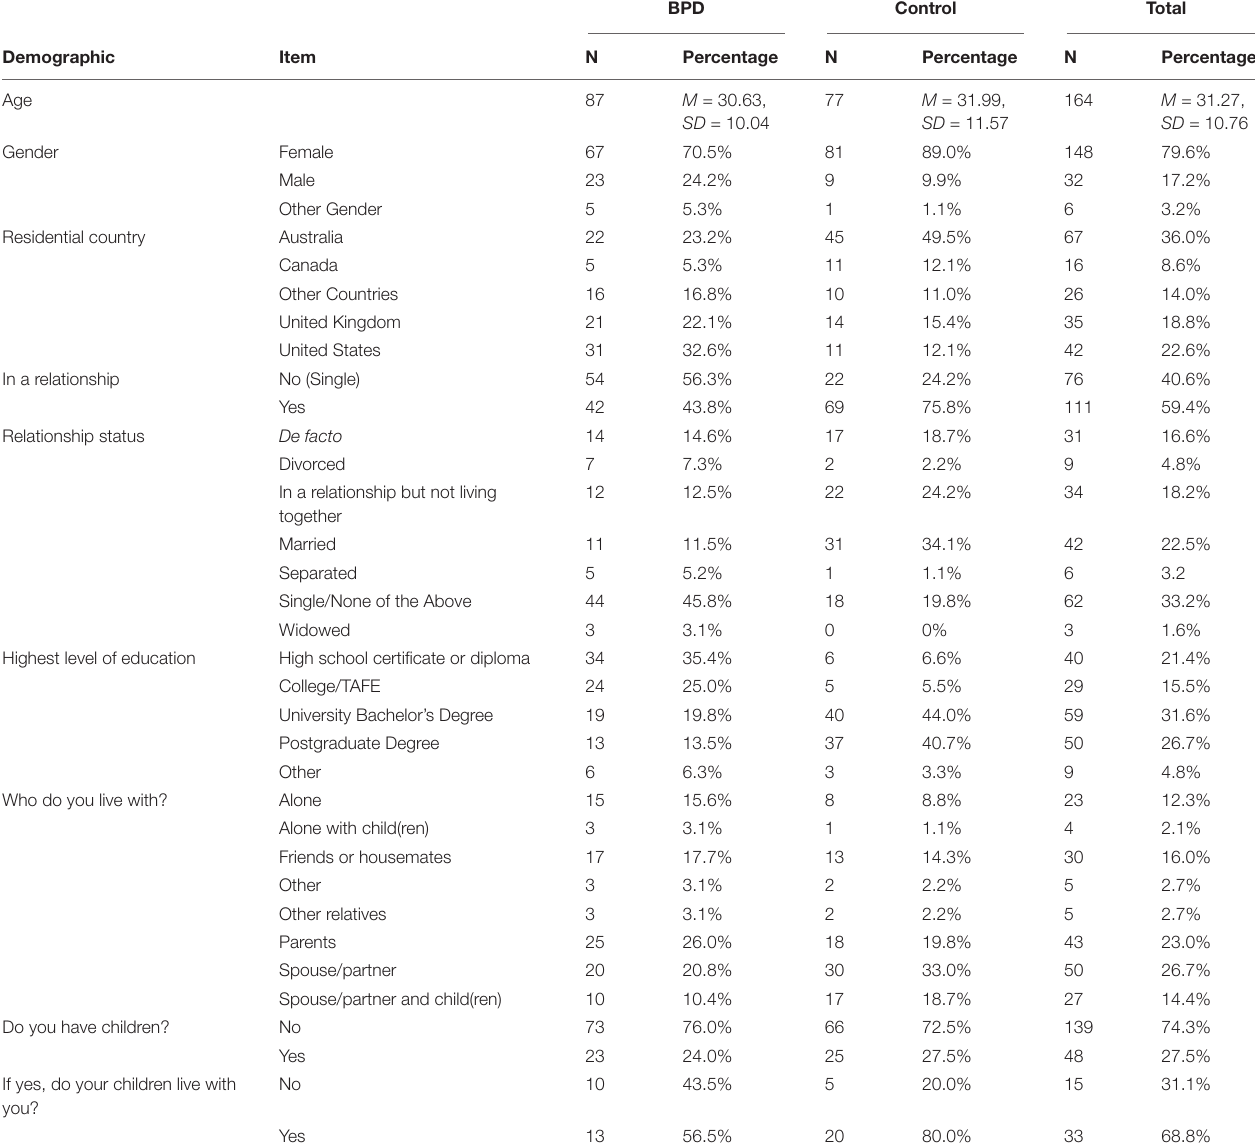
TABLE 1 | Demographics and percentages for BPD sample ( N = 96) and Control Sample ( N =